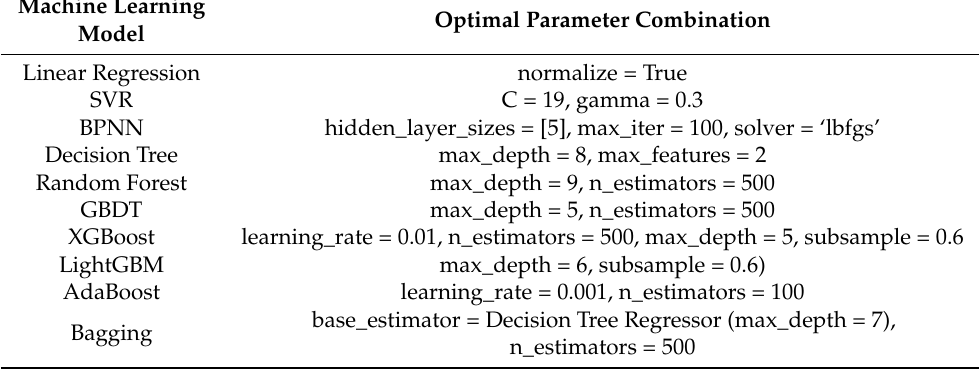
Table A1. Machine Learning Model Parameter Optimization